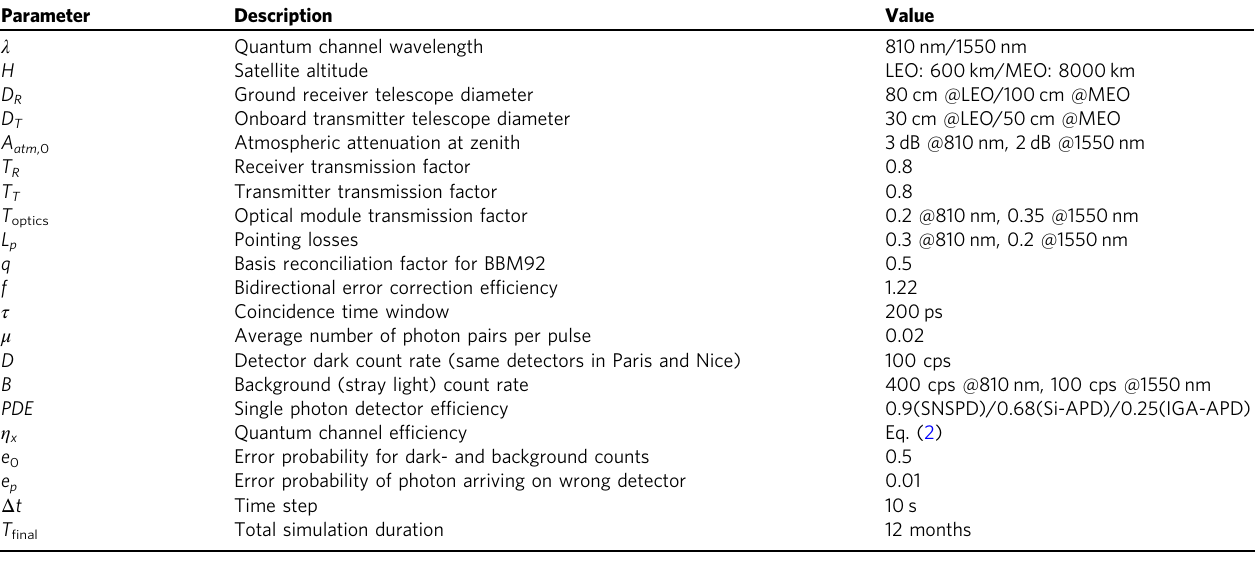
Table 2 Simulation input parameters as discussed in subsection “ Towards a resource demonstration system". Parameter